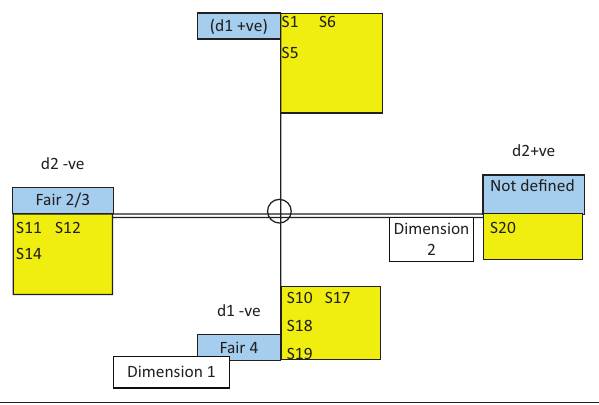
FIGURE 1: Bi-plot illustrates the relationship between statements and fairness